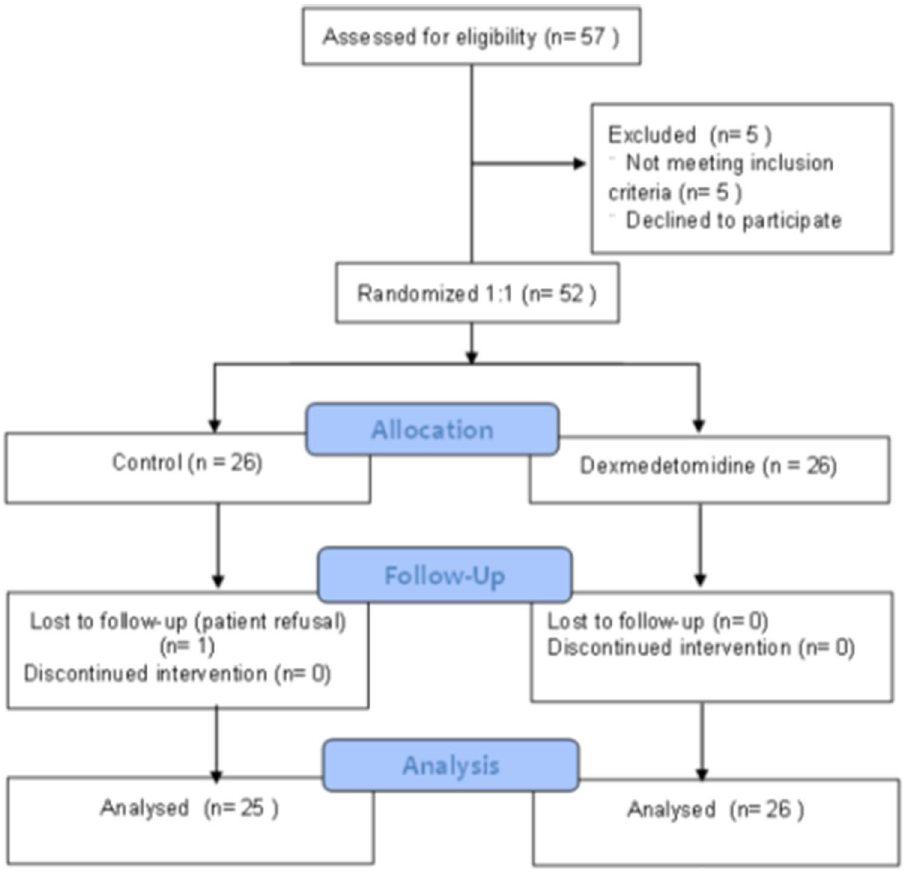
Figure 1. Flow chart showing the patient enrollment process based on CONSORT